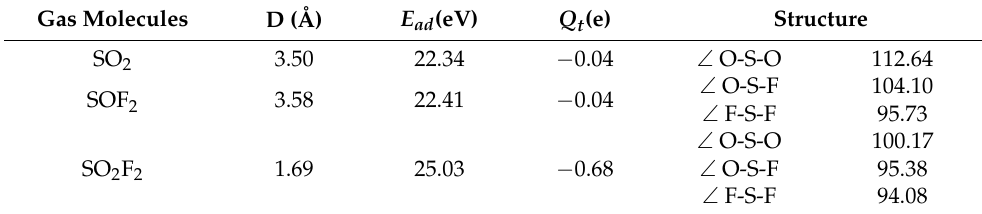
Figure 6. The energy band of ( a ) MoS 2 /SO 2 ( b ) MoS 2 /SOF 2 ( c ) MoS 2 /SO 2 F 2 adsorption system. Table 3. Parameters of adsorption of the target gases on MoS 2 surface.